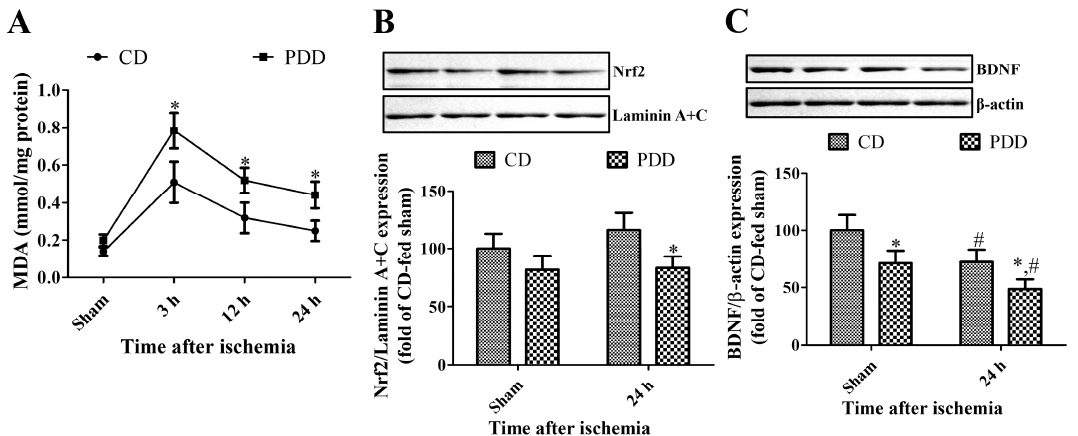
Figure 5. Measurement of malondialdehyde (MDA) levels ( A ) in the hippocampus and Western blot analysis of nuclear Nrf2 ( B ) and total mature brain-derived neurotrophic factor (BDNF) levels ( C ) in the CD- and PDD-fed gerbils of sham- and ischemia-operated groups ( n = 6–7 per group; * p < 0.05, significant difference between CD- and PDD-fed groups; # p < 0.05, significant difference between sham- and ischemia-operated groups). All data are expressed as mean with standard deviation.